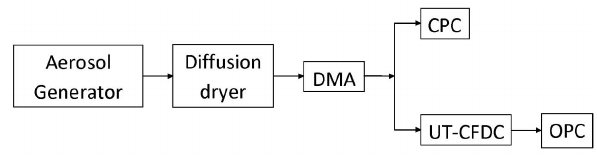
Fig. 1. Schematic of the main components of the experimental set-